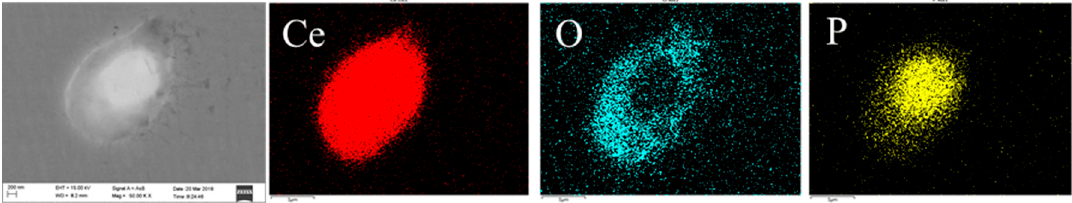
Figure 5. The morphology and composition of the typical Ce–O–P stratified composite inclusion.